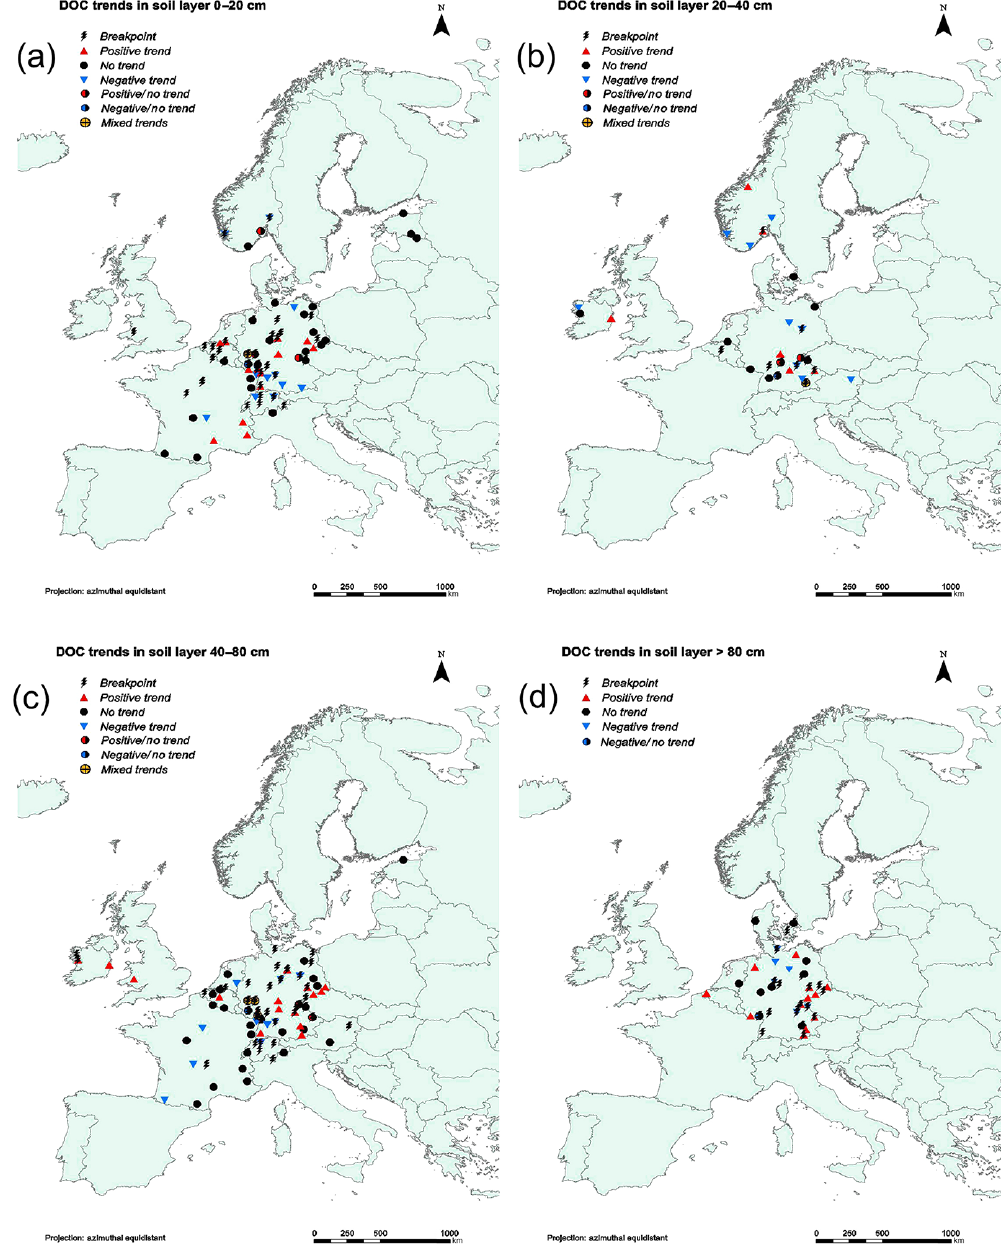
Figure 4. Directions of temporal trends in soil solution DOC concentration at plot level in the mineral soil for soil layers: (a) topsoil (0–20cm), (b) intermediate (20–40cm), (c) subsoil (40–80cm) and (d) deep subsoil (>80cm). Trends were evaluated using the seasonal Mann–Kendall test. Data span from 1991 to